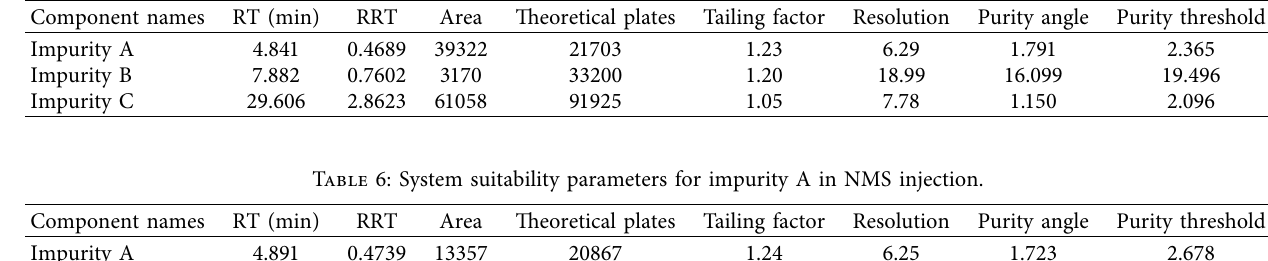
Table 5: System suitability parameters for neostigmine methylsulfate impurities in API.